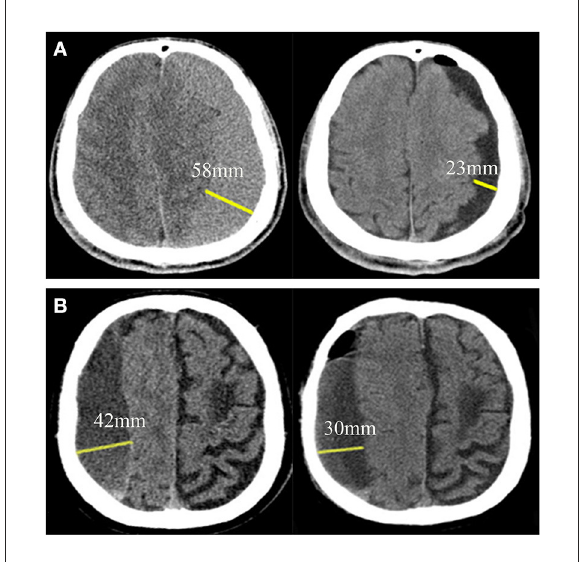
FIGURE3 Brain re-expansion in patients with chronic subdural hematoma at postoperative 7–9 th day. (A) A patient with good brain re-expansion. The maximum thickness before surgery and 7–9 days after surgery were 58and 23mm, respectively, and the postoperative brain re-expansion rate was 60.34%. (B) Another patient with partial brain re-expansion. The maximum thickness before surgery and 7–9 days after surgery were 42 and 30mm, respectively, and the postoperative brain re-expansion rate was